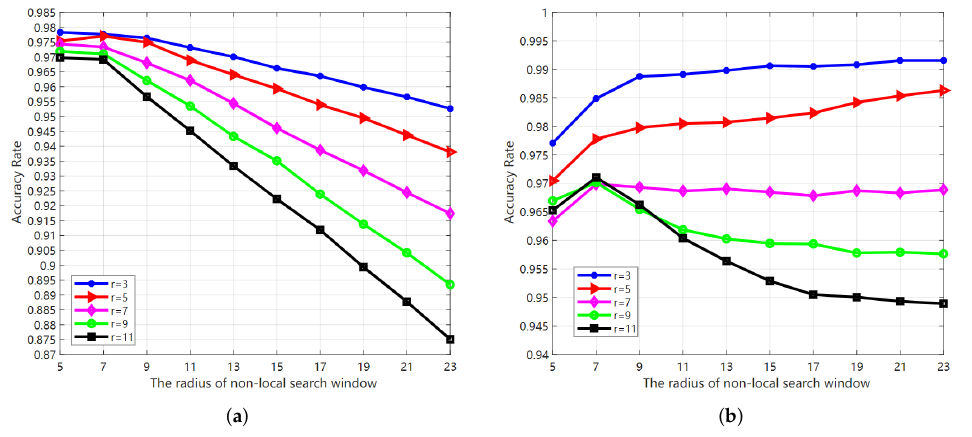
Figure 18. The SA (%) of LBNL_FCM and GLR_FCM carried out on the first simulated SAR image with different sizes of search window w × w and different sizes of local neighborhood r × r .